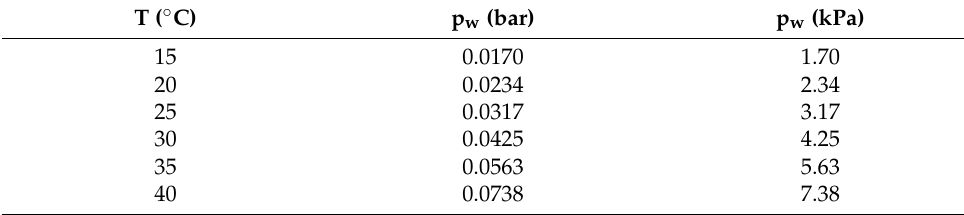
Table 13. Saturation vapour pressure p w